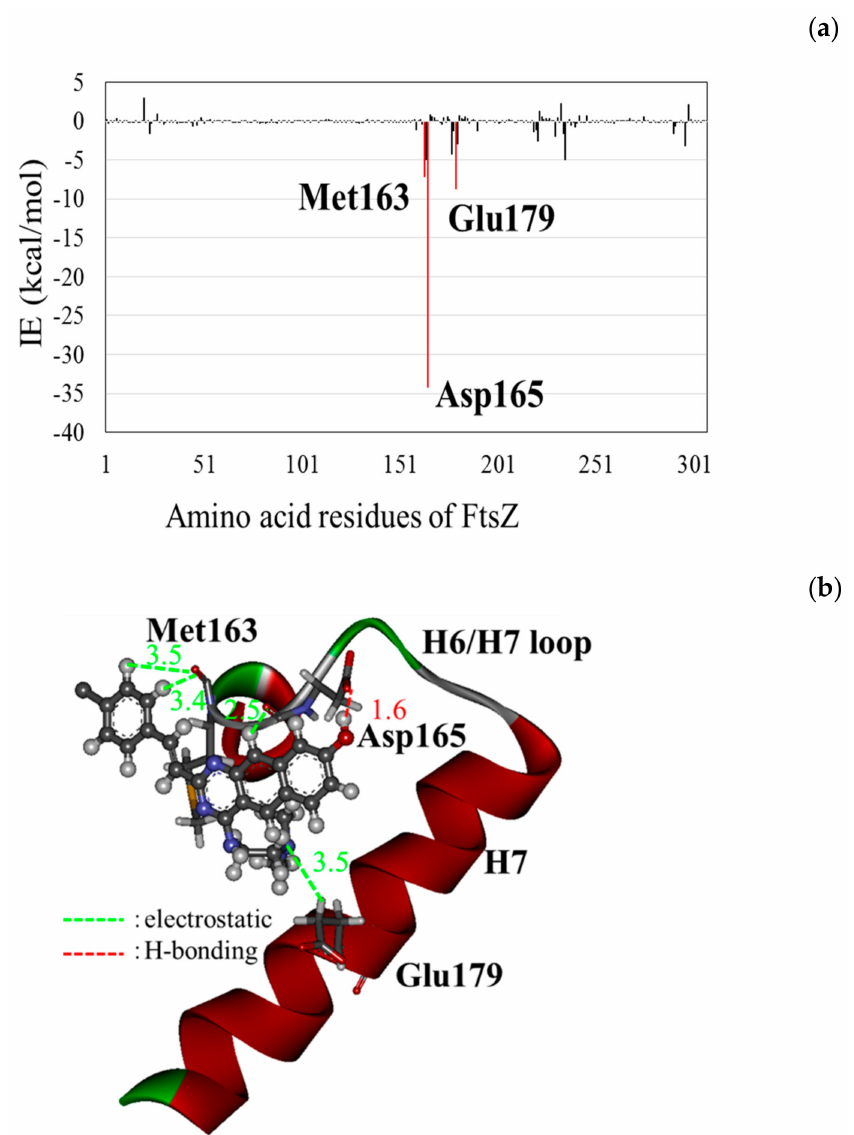
Figure 6. ( a ) Interaction energies (IE) and ( b ) an interacting structure between ZZ3_X (ball-and-stick model) and FtsZ residues (stick